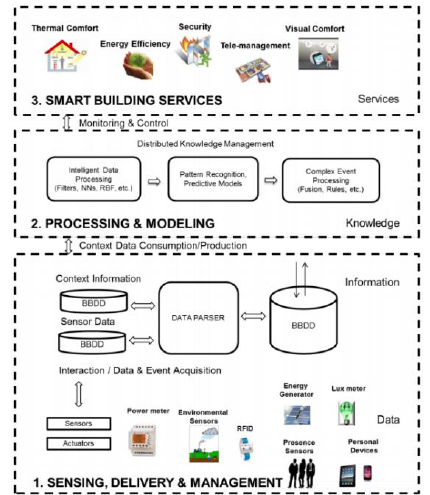
Figure 1. Conceptual layered approach for smart buildings [17].